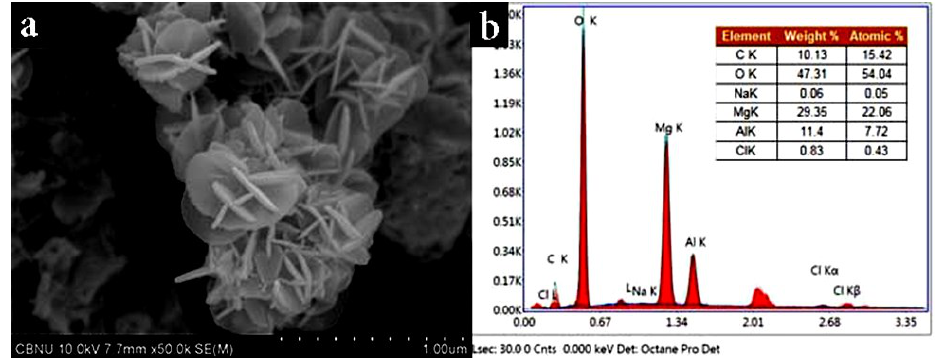
Fig. 2. SEM image of Mg/Al LDH and their EDX results.